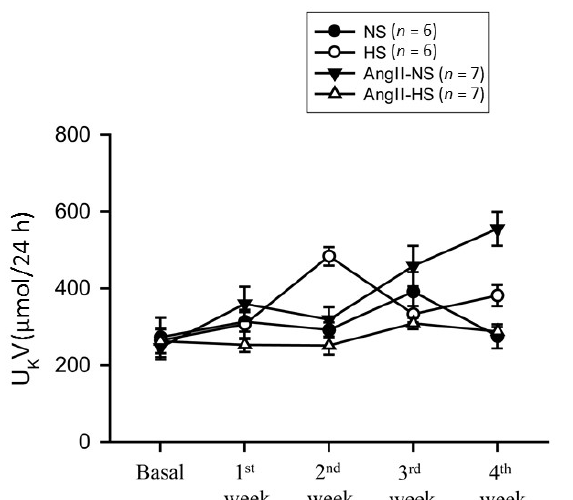
V responses to chronic AngII (25 ng/min) infusion in mice given NS (NS; 0.3% NaCl) and HS (HS; 4% NaCl) Figure 5. U K containing diets